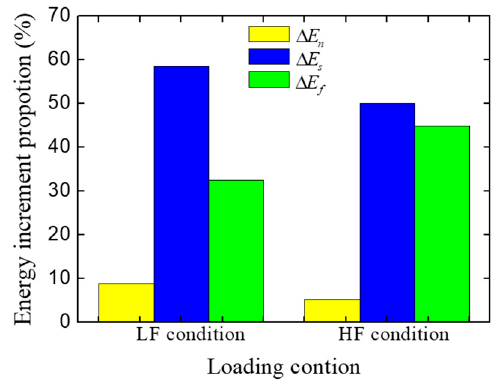
Figure 19. Energy increments proportion of the concrete specimen in different loading conditions at the pre-peak stage.